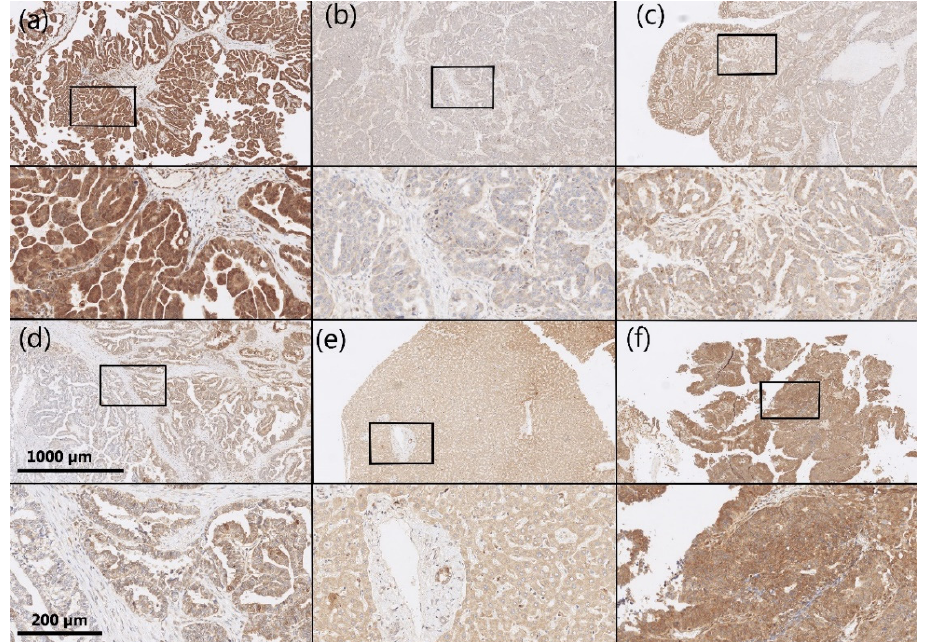
Figure 4. Representative immunohistochemical AKR1B10 staining in HGSC samples and control tissue. ( a – d ) HGSC; ( e ) control liver tissue; ( f ) control endometrioid endometrial cancer. Upper half of panels: 50 × magnification; lower half of panels: the framed area from the upper half of the panel (200 × magnification). AKR1B10: aldo-keto reductase family 1 member B10; HGSC: high-grade serous ovarian cancer.